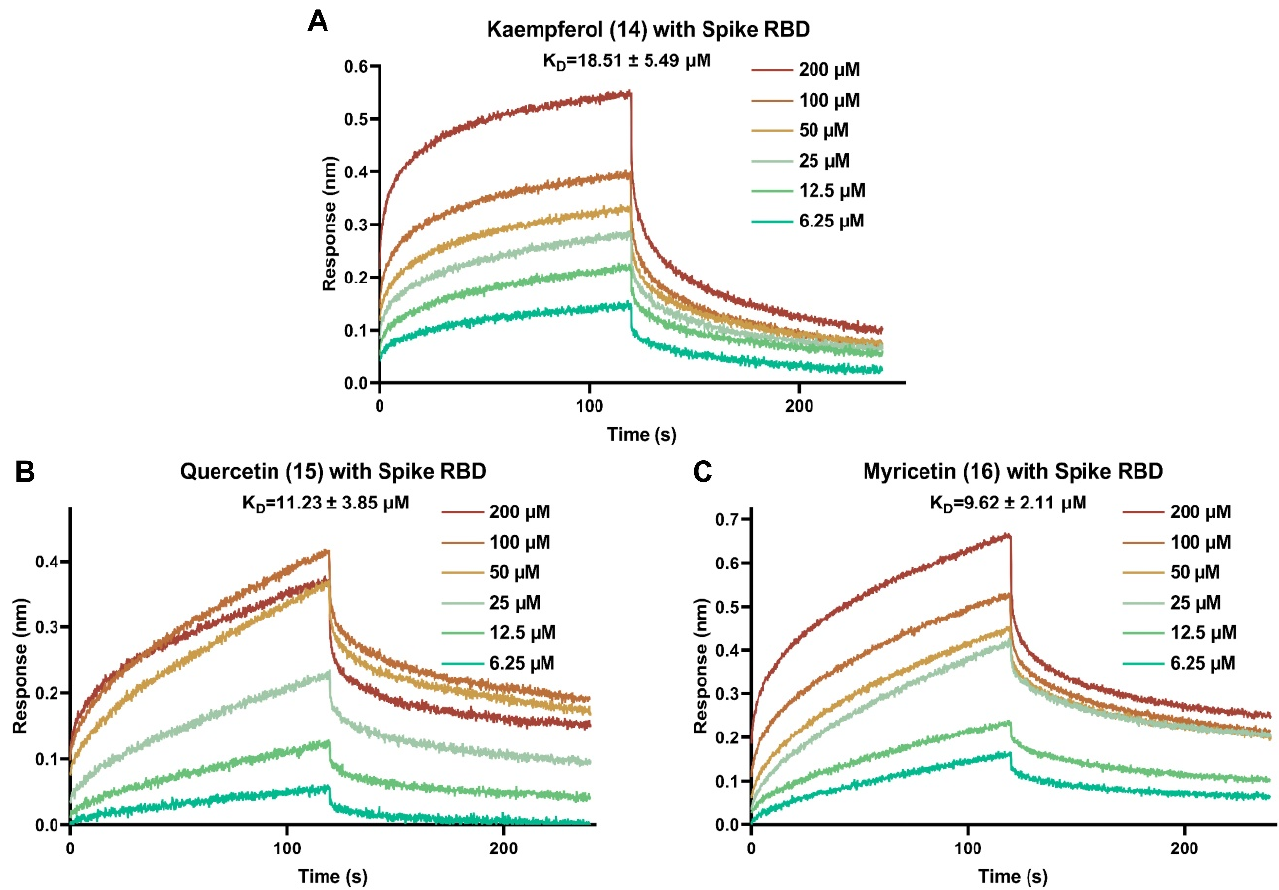
Figure 4. Binding curves of selected bioactive flavonoids with SARS-CoV-2 spike RBD by BLI binding kinetics assay. ( A ) The interaction of kaempferol with viral spike RBD protein; ( B ) the interaction of quercetin with viral spike RBD protein; ( C ) the interaction of myricetin with viral spike RBD protein.